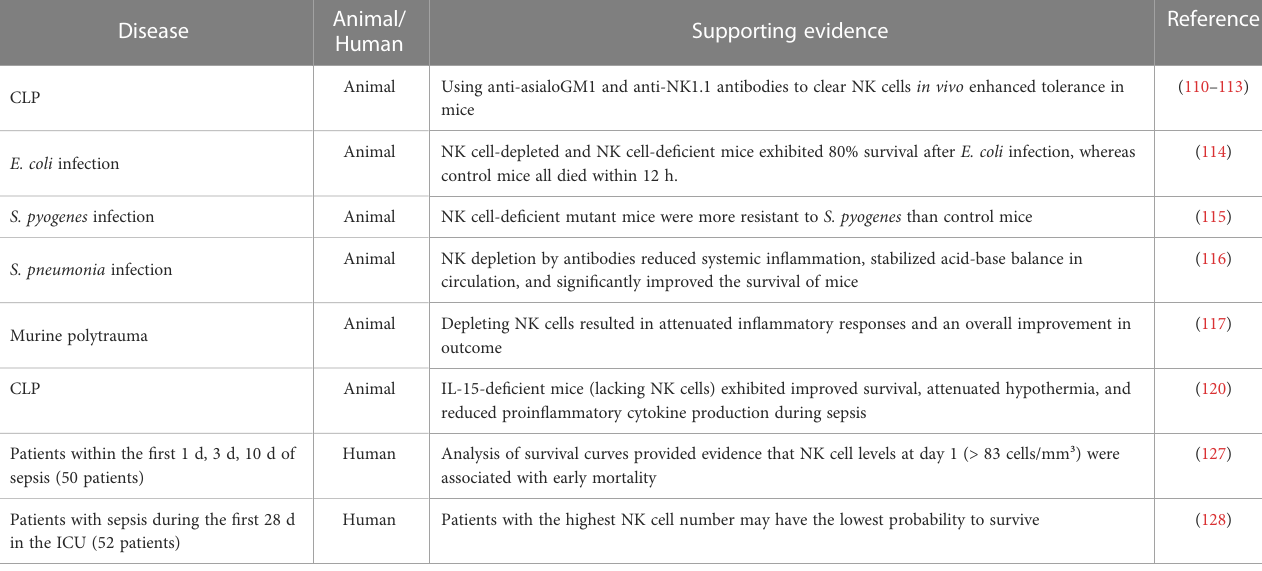
TABLE 1 Summary of the detrimental roles of NK cells in sepsis.